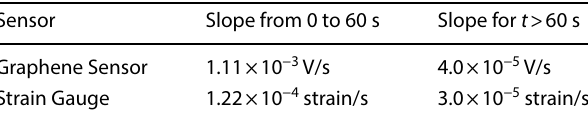
Table 3 Correlation between the signals from the graphene sensor and the strain gauge Sensor Slope from 0 to 60 s Slope for t > 60 s Graphene